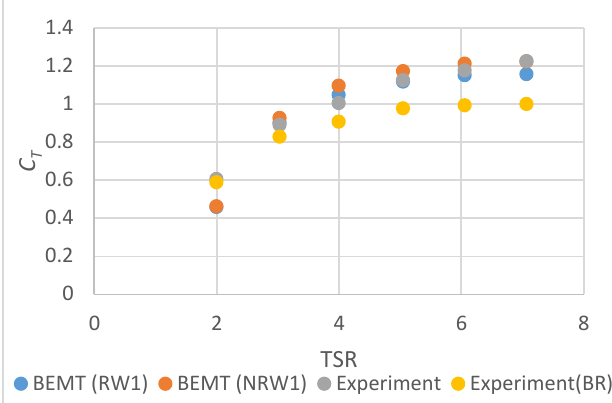
Figure 12. C T comparison between BEMT calculations and experimental data for the inflow profiles with and without a turbine when the turbine operates under wave-current interactions with a wave height of approximately 0.19m and an apparent wave period of 0.7s.